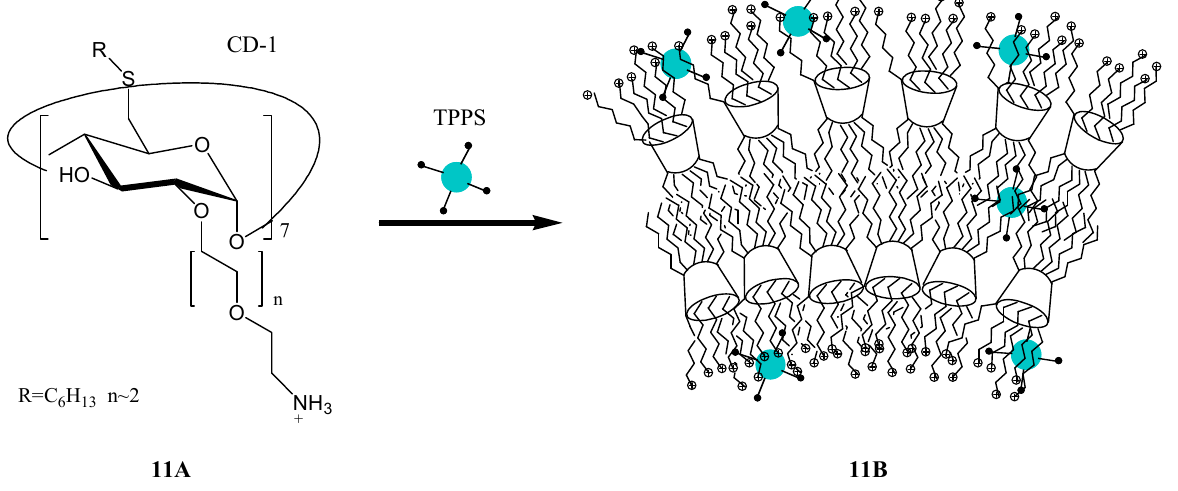
Figure 12. Formation of biocompatible nanoparticles ( 11B ) of cationic amphiphilic cyclodextrins entangling the anionic